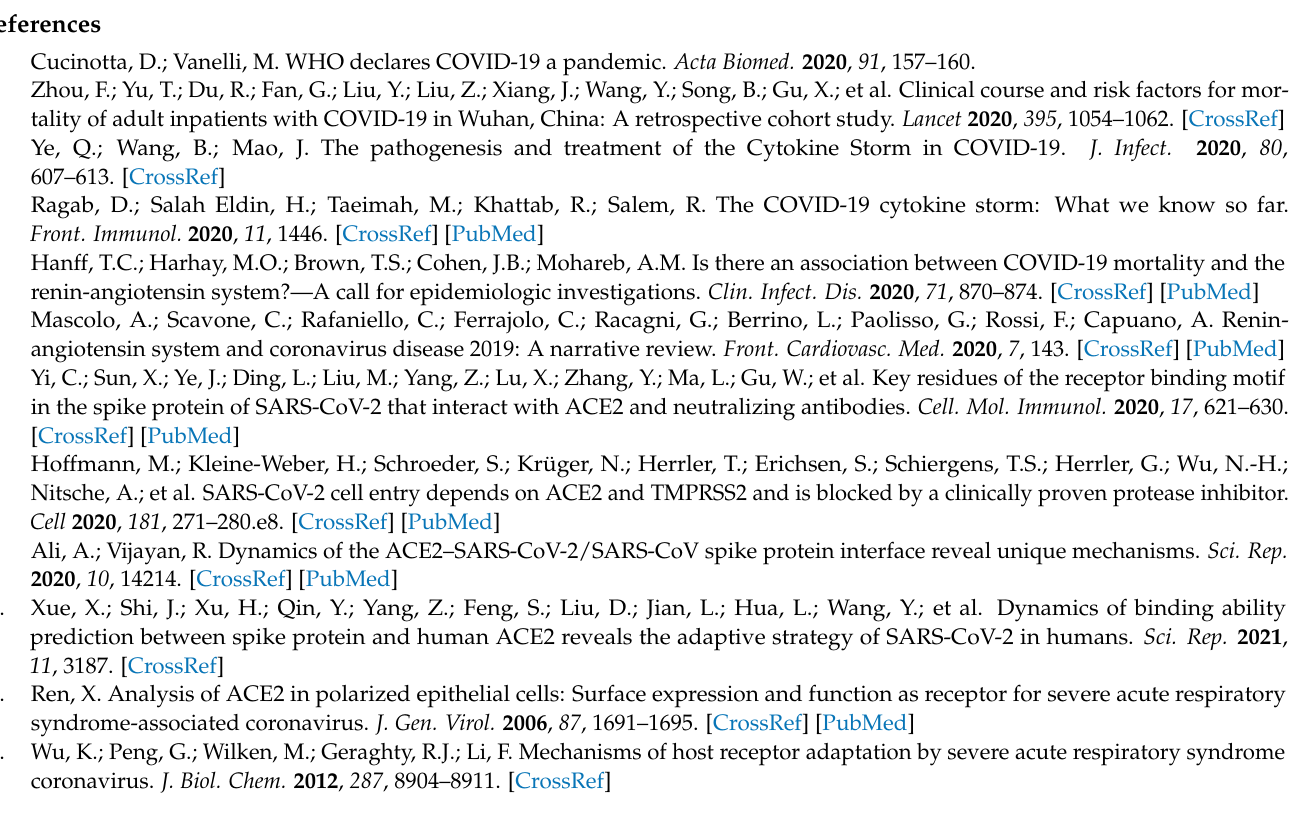
cell proteins, Table S1: Original evidence for the depicted connections for “immune response– inflammation”, Table S2: Original evidence for the depicted connections for “immune response– complement system”, Table S3: Original evidence for the depicted connections for “blood and coagulation system”, Table S4: Original evidence for the depicted connections for “organ-specific diagnostic markers”, Table S5: Concordance between common interactions and experimental data, Table S6: Characterization of potential heme-binding motifs within SARS-CoV-2 proteins and human host cell